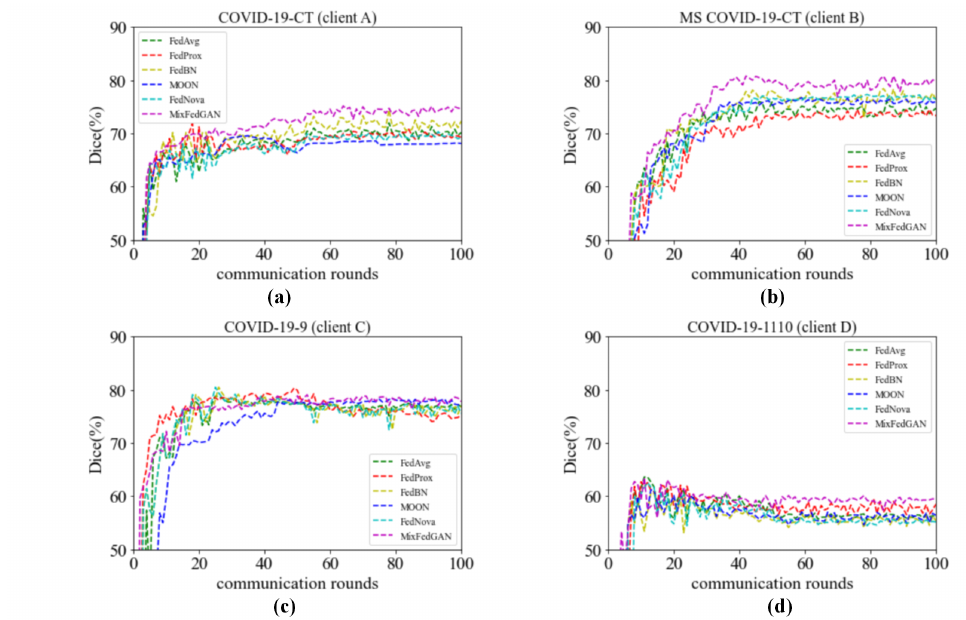
Figure 7. ( a ) Client A’s convergence in terms of testing dice with communication rounds. ( b ) Client B’s convergence in terms of testing dice with communication rounds. ( c ) Client C’s convergence in terms of testing dice with communication rounds. ( d ) Client D’s convergence in terms of testing dice with communication rounds.